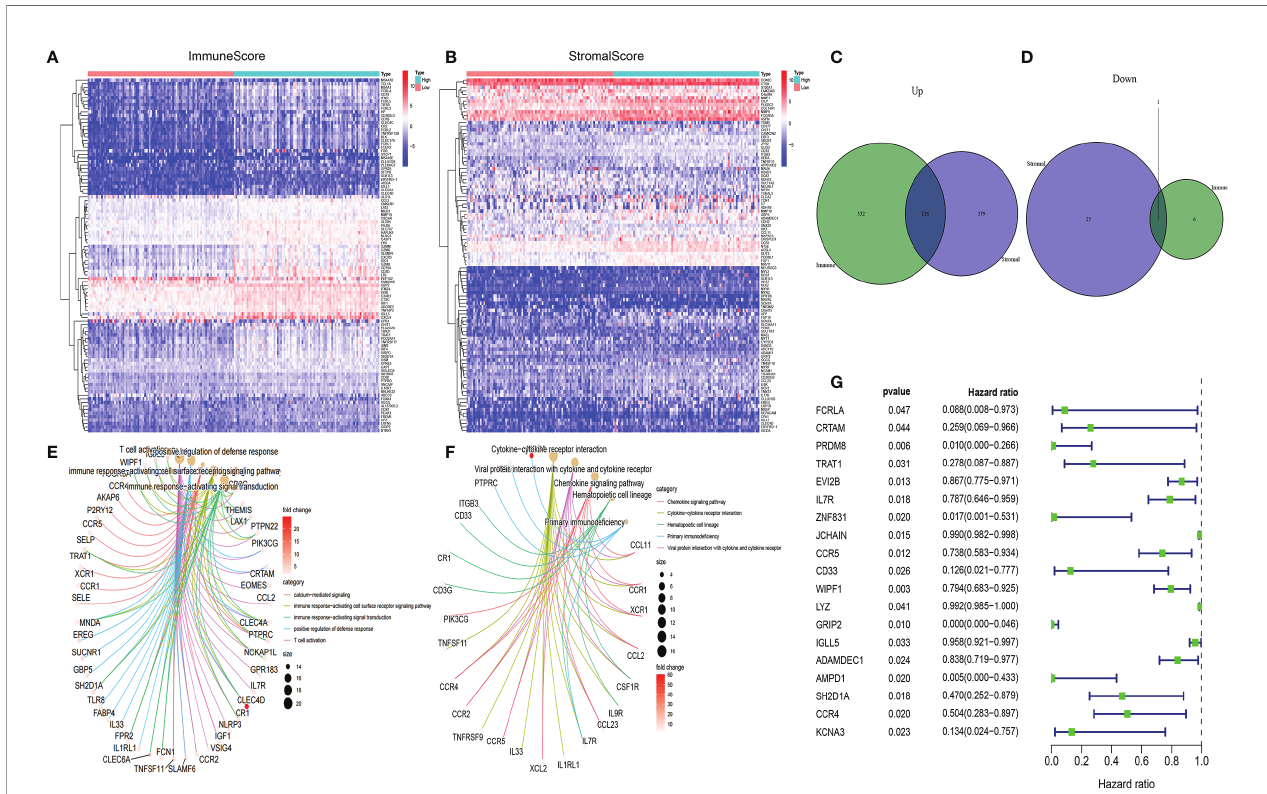
FIGURE 3 | Heatmaps, Venn diagrams, GO, KEGG enrichment and univariate Cox analyses of differentially expressed genes (DEGs) in HER2+ BC. Heatmaps of signi fi cant DEGs (FDR-adjusted p < 0.05, |log FC| > 1) between high and low (A) ImmuneScore and (B) StromalScore groups. Venn diagrams of upregulated and downregulated DEGs shared by the (C) ImmuneScore and (D) StromalScore analyses. (E) GO and (F) KEGG enrichment analyses (p < 0.05 and q < 0.05). (G) Univariate Cox regression analysis 127 DEGs, showing genes with p <